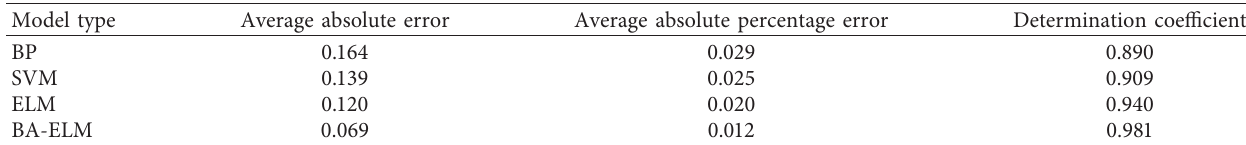
Figure 6: Prediction results of different methods. Table 4: Errors and determination coefficients of different prediction